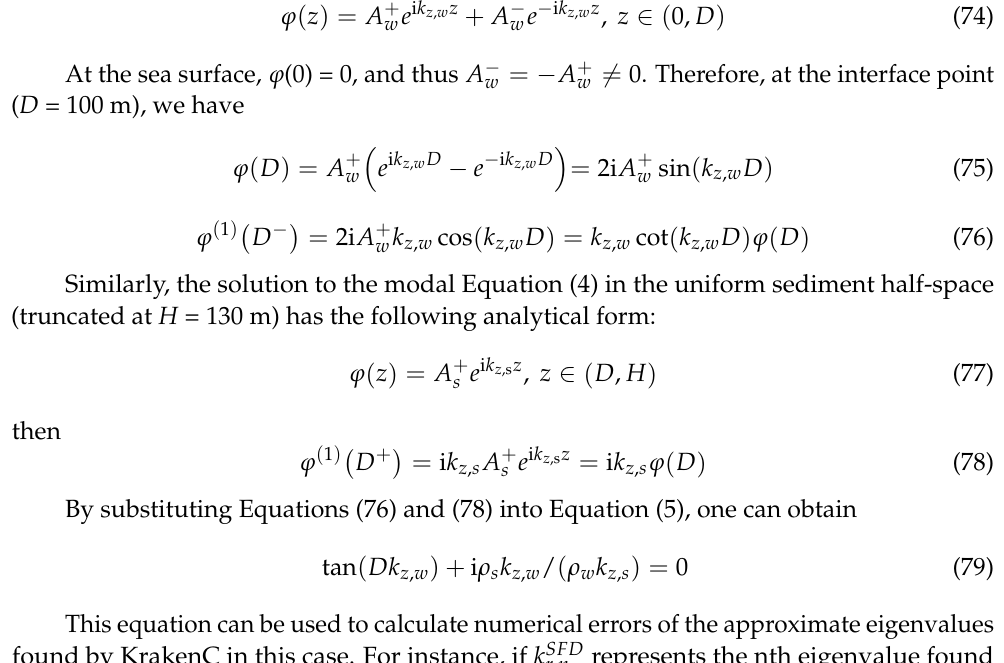
Figure 5. The real and imaginary parts of solutions in the plane-wave reflection case with PPW = 20.